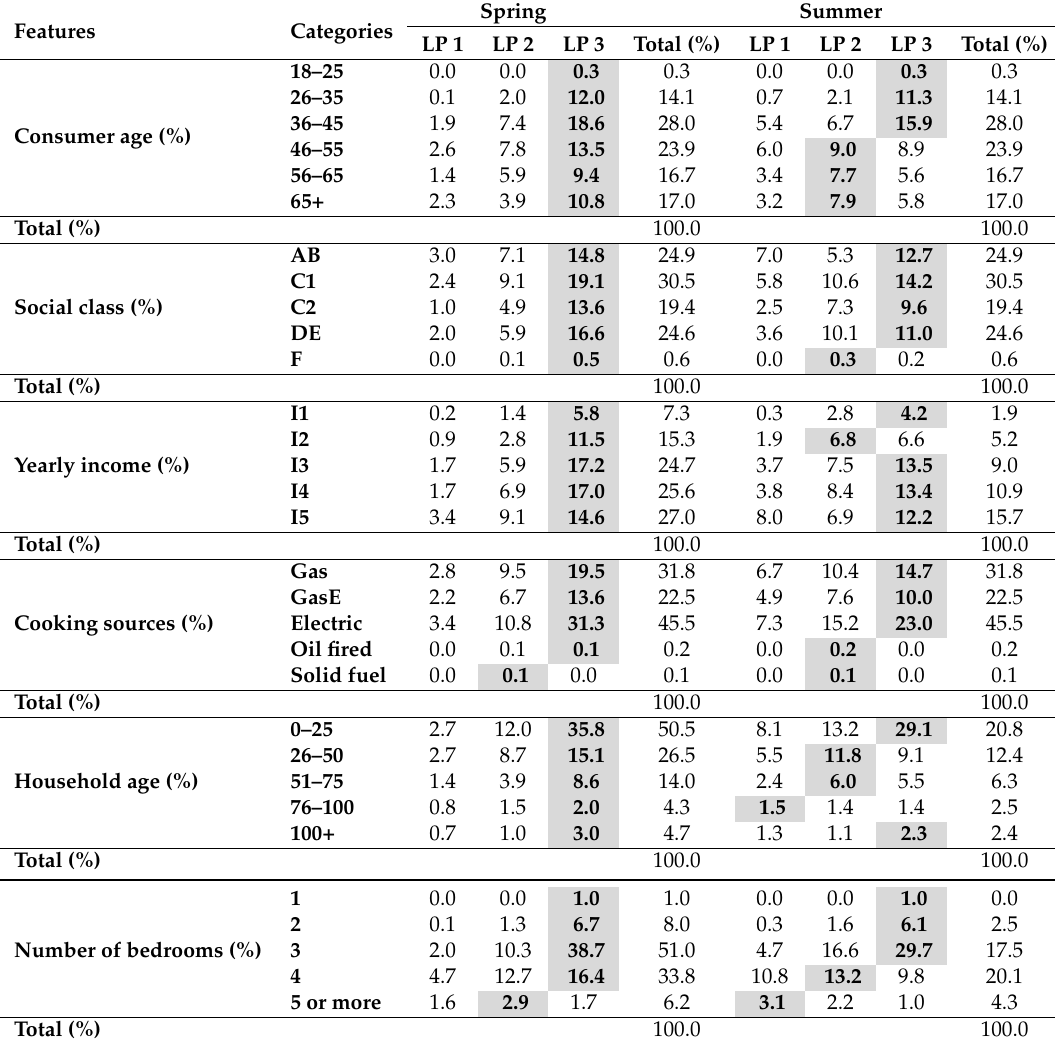
Table 6. Key features for each normalized LP in spring and summer, where the percentage values of the most representative categories for the population are highlighted in bold